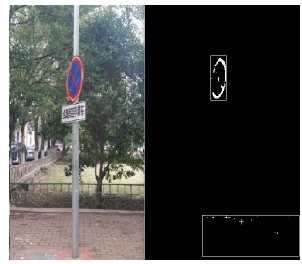
Figure 2: The Interest Areas Extracted By Our Algorithm